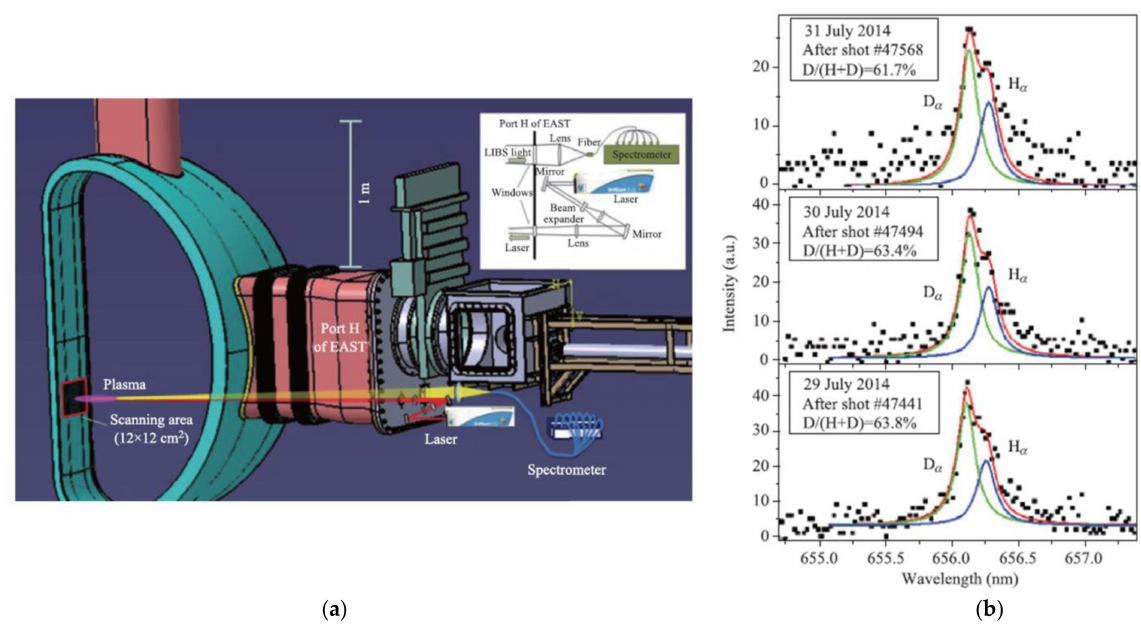
Figure 14. LIBS in fusion materials analysis. ( a ) Schematic of a stand-off LIBS system installed at the EAST tokamak in China. ( b ) In situ LIBS spectra with H α and D α lines measured on different days at EAST. Adapted from